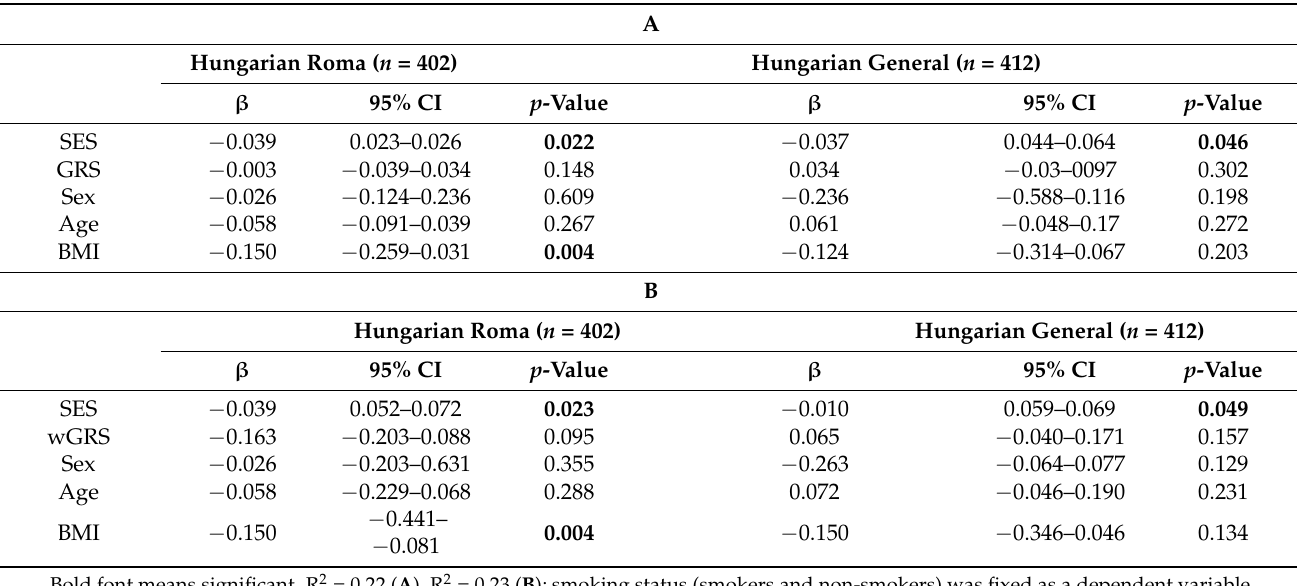
Table 3. Association of SES with smoking status by study